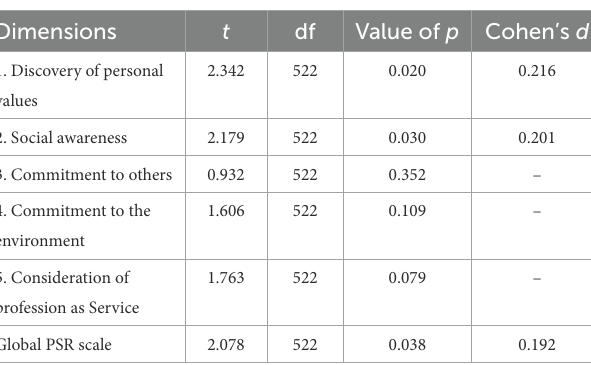
TABLE 4 Student’s t test for independent samples.